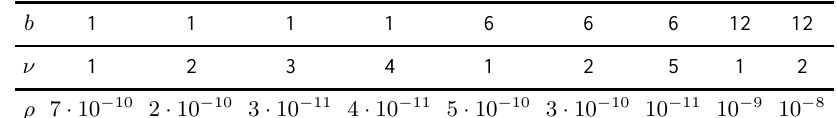
Table 9. Example 2 (Spline parameters: k = 10 ; N = 10 ; j = 3)